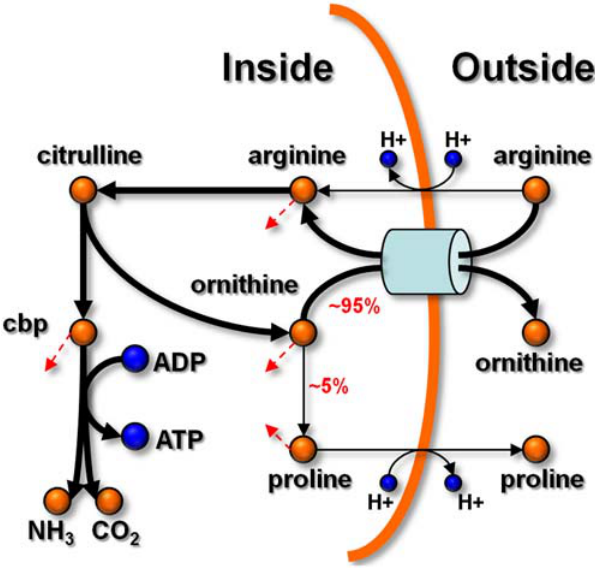
Figure 3. Arginine, proline and ornithine metabolism. Prior to its depletion, arginine exhibits the highest uptake rate among the supplied nutrients. Most of it is deaminated to citrulline, which is then converted to ornithine and carbamoyl-phosphate (cbp). Most of the ornithine ( < 95%) is transported outside through an arginine-ornithine antiporter. On the other hand, carbamoyl phosphate is primarily degraded to NH 3 and CO 2 in a reaction that produces ATP from ADP. Simulations show that at the beginning of growth this process produces most of the energy in the cells. The red broken arrows indicate connections to other parts of the